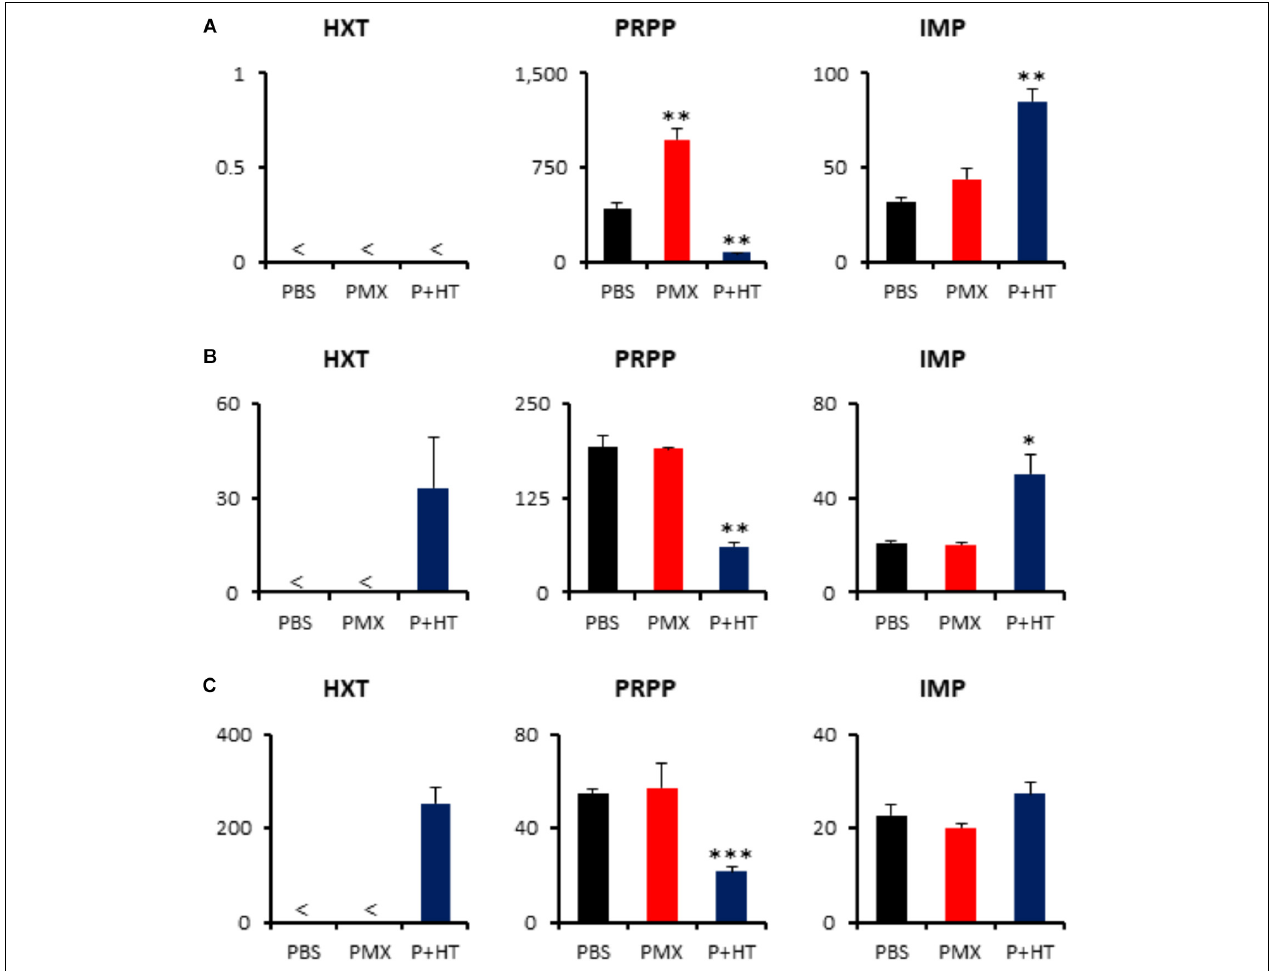
FIGURE 6 | Quantification of metabolites involved in purine salvage pathway. Intracellular concentration (pmol/million cells) of key metabolites involved in the purine salvage pathway after treatment of pemetrexed is shown. Error bars indicate s.d. (n = 3) and < indicates the metabolite was not detected (N.D.). ∗ P < 0.05, ∗∗ P < 0.01, ∗∗∗ P < 0.001 vs. control by Welch t -test. Total metabolites were extracted with methanol from MSTO-211H (A) , TCC-MESO2 (B) , or NCI-H2452 (C) cells treated with PBS (black), 1 µ M PMX (red) or 1 µ M PMX + HT (blue) for 6 h. Representative metabolites including hypoxanthine (HXT), PRPP, and IMP are